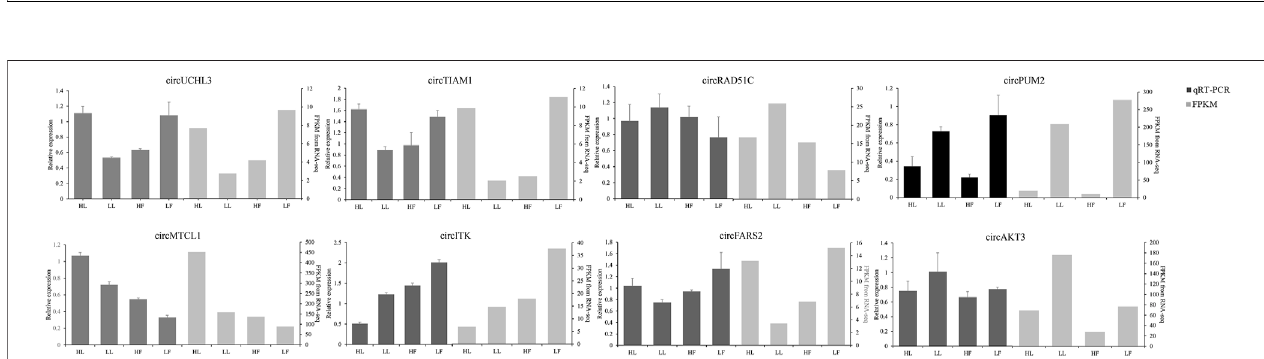
FIGURE 4 | Comparison of the results of DE circRNAs in RNA-seq and RT-qPCR analysis.